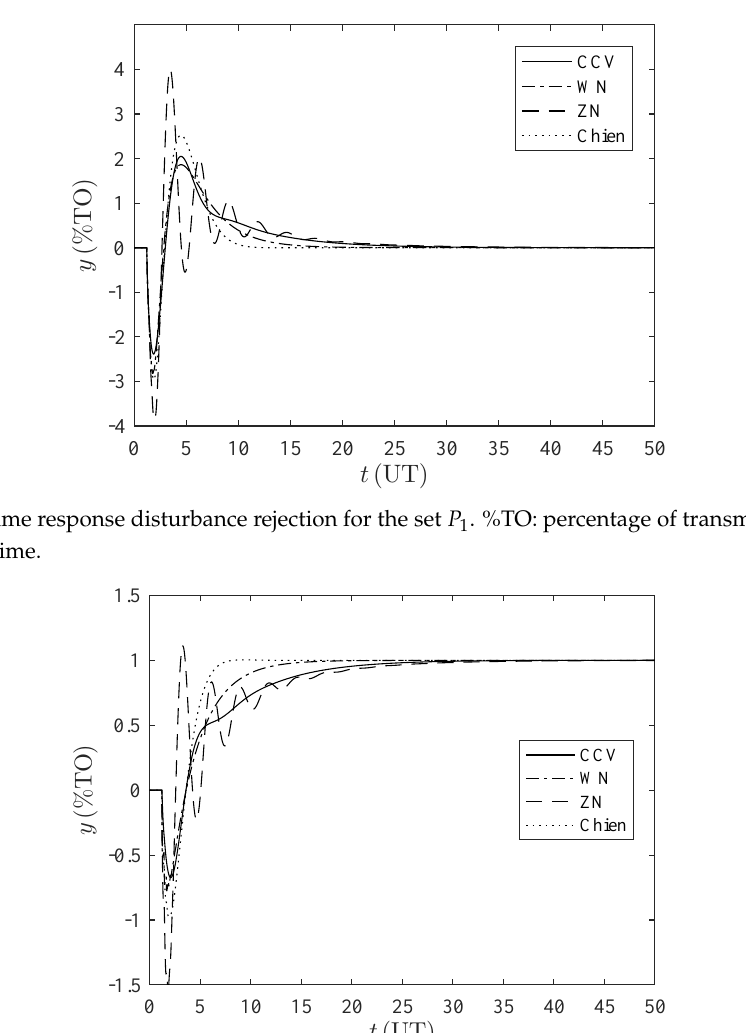
Figure A2. Time response set-point tracking for the set P 1 . %TO: percentage of transmitter output, UT: units of time.